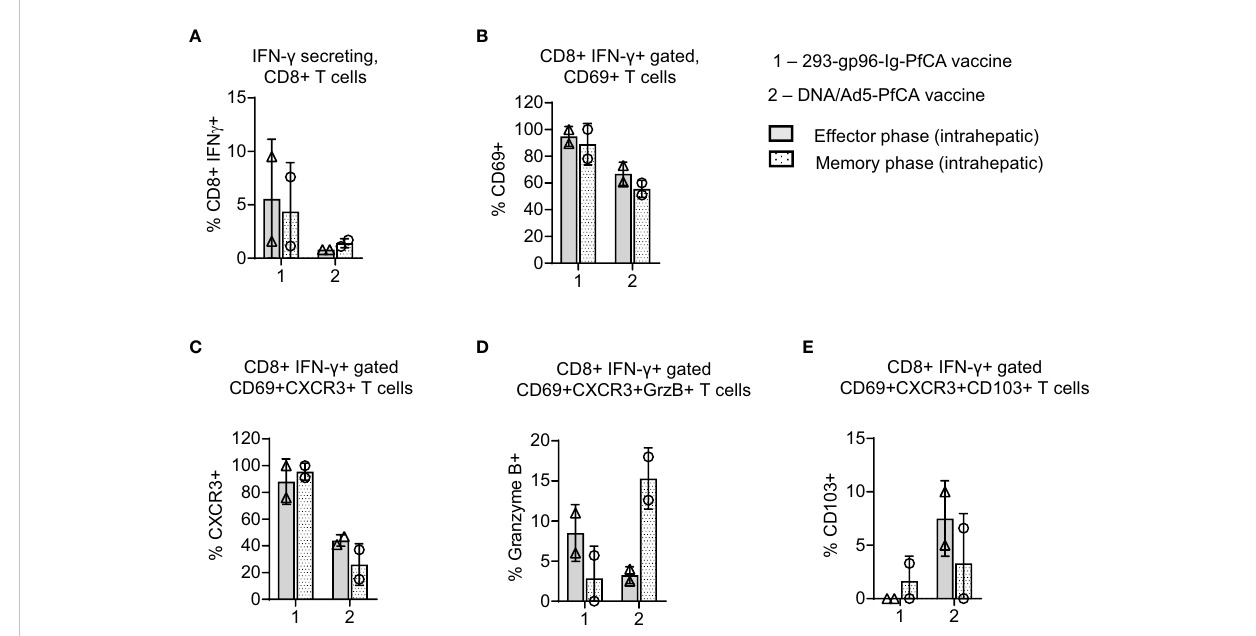
FIGURE 5 293-gp96-Ig-PfCA vaccinated rhesus macaques induce PfAMA1 speci fi c CD8+ T cell memory responses in the liver. Characterization of PfAMA1- speci fi c, intrahepatic memory CD8+ T cell responses in rhesus macaques at effector (1 week, n=2) and memory (11 weeks, n=2) time-points following the third dose of the 293-gp96-Ig-PfCA vaccine. Control animals received DNA/Ad5-PfCA vaccine and sacri fi ced at effector (3 weeks, n=2) and memory (11 weeks, n=2) time-points following the Ad5 boost. Optimal effector time-points of the two vaccines were determined based on the results of the prior studies. Intrahepatic lymphocytes were cultured overnight in medium only or with pool of overlapping PfAMA1 peptides. Cells were stained for surface CD3, CD8, CD69, CXCR3, CD103 and intracellular cytokine IFN- g and granzyme (B) Cells were analyzed by fl ow cytometry to determine the frequency of (A) IFN- g secreting CD8+ T cells (B) CD8+IFN- g + gated CD69+ (C) CD8+IFN- g + gated CD69+CXCR3+ (D) CD8 +IFN- g + gated CD69+CXCR3+GranzymeB+ and (E) CD8+IFN- g + gated CD69+CXCR3+CD103+ cells. Data represent individual values and mean ± standard